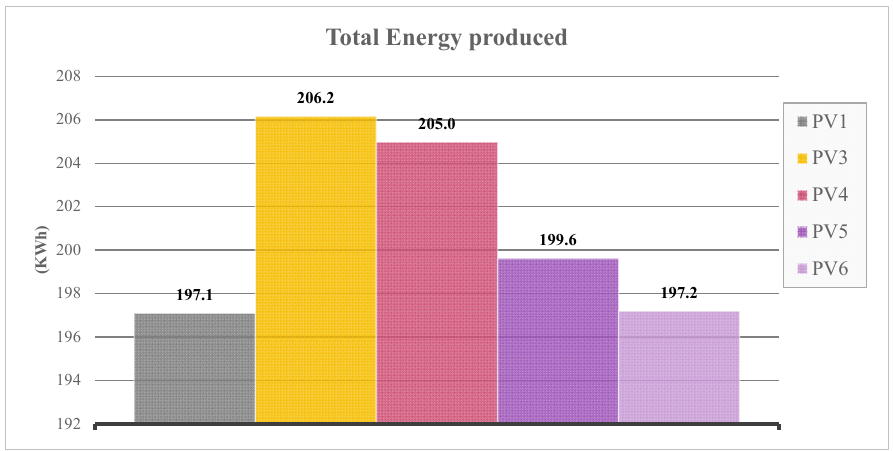
Figure 7. Monthly energy production of the reference module and the four PV modules equipped with the cooling sys- tems.